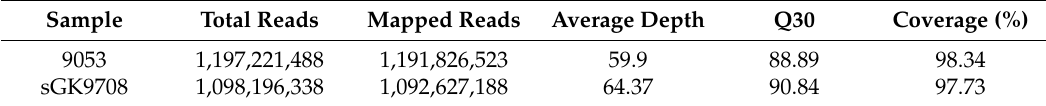
Table 1. Summary of sequence data and mapping statistics on the reference